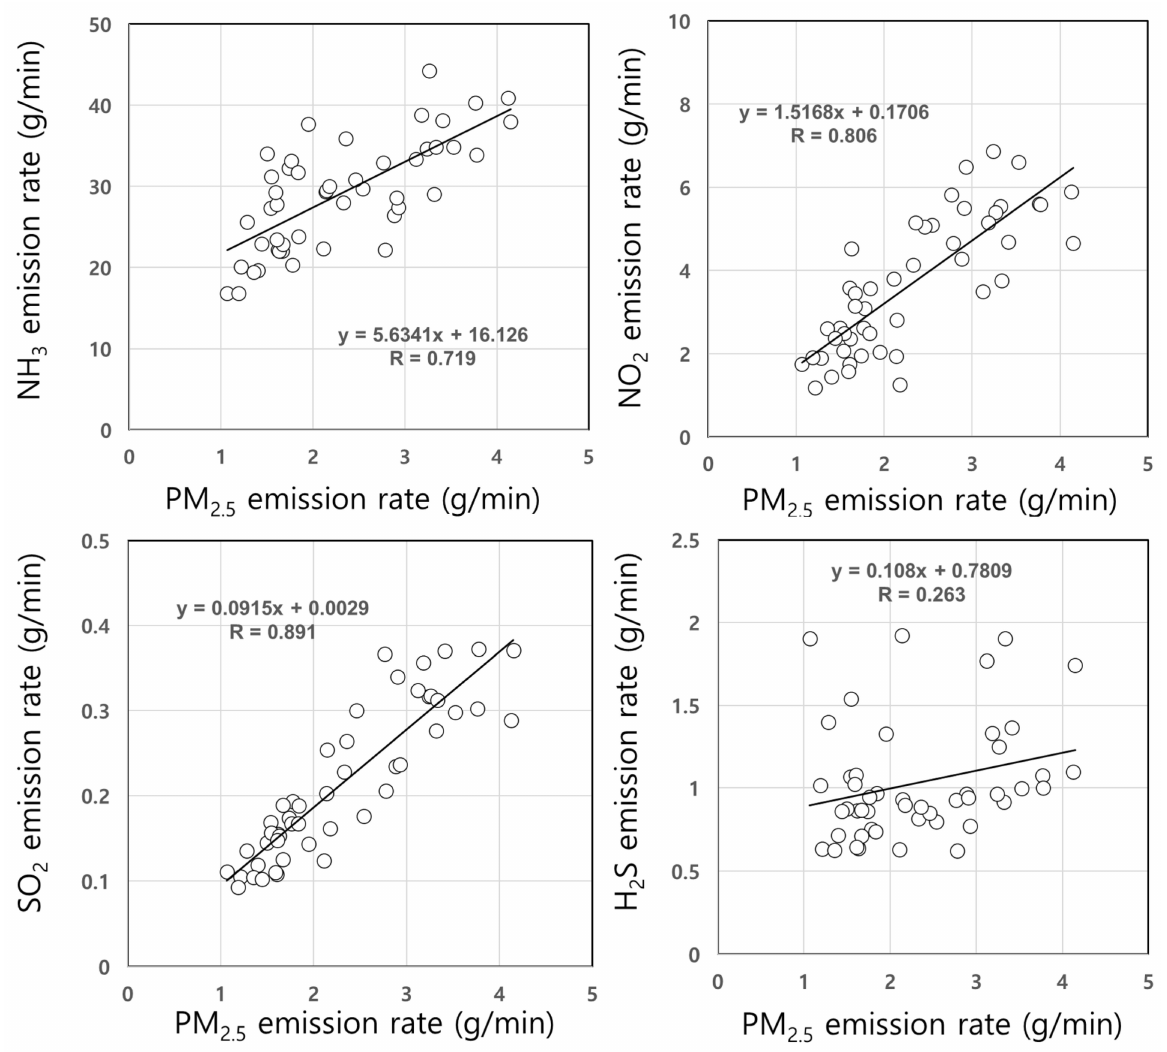
Figure 6. Correlations between PM 2.5 mass emission rates and gaseous air pollutant emission rates at the barns ( p -values < 0.001 for NH 3 , NO 2 , and SO 2 , and p = 0.071 for H 2 S,